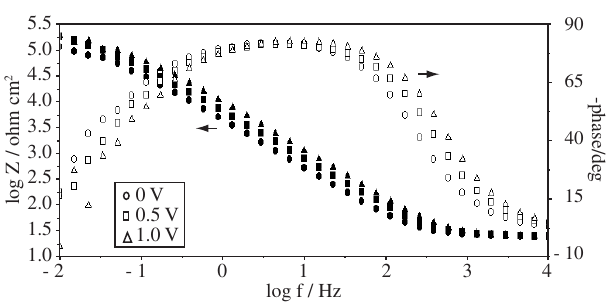
Figure 10. Bode plots of Ti6Al4V obtained in the presence of bromide after anodic polarization at 0 ( ● ), 1.0 ( ▲ ) and 2.5 ( ∎ ) V.